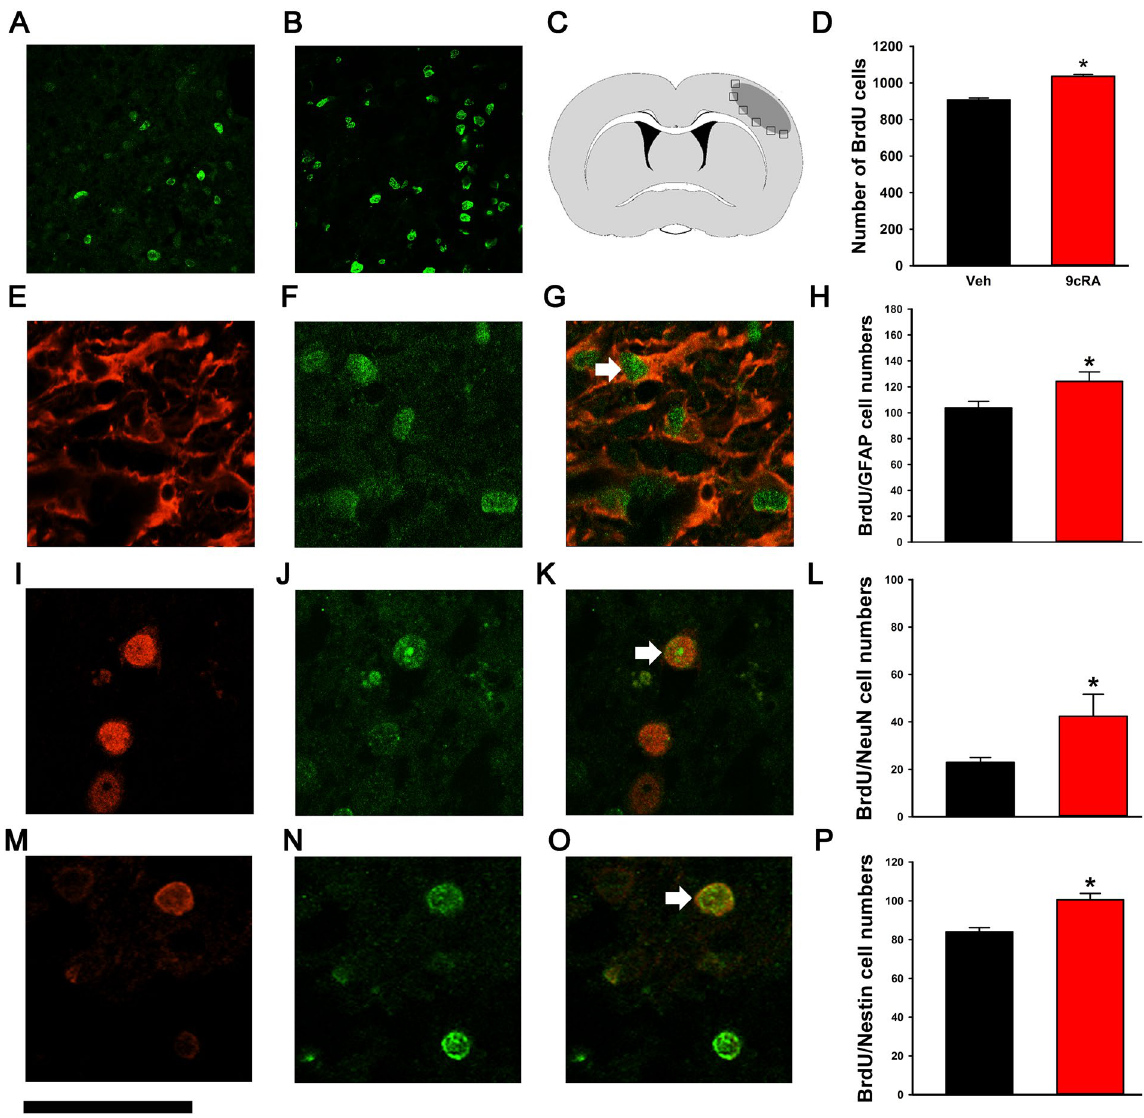
Figure 5. Post-stroke treatment with 9cRA increased BrdU immunoreactivity and cell differentiation in the lesioned cortex. Stroke animals (n = 13) received 9cRA (n = 6) or saline (n = 7) from days 3 to 14. BrdU was given (50 mg/kg, bid) from days 3 to 14. Animals were sacrificed on day 15. Representative BrdU immunoreactivity in the peri-lesioned area of animals receiving ( A ) vehicle and ( B ) 9cRA. The density of BrdU-labeled cells in the peri-lesioned zone (boxes surrounding the lesioned or shaded area) was measured and averaged from three adjacent sections at the level of the anterior commissure ( C ). ( D ) Intranasal administration of 9cRA significantly increased the number of BrdU-positive cells per visual field (410 × 410 µ m) in the lesioned cortex (p < 0.001, t-test). Confocal microscopy was used to examine the colocalization of the immunoreactivity of BrdU ( F , J , N ) with GFAP ( E ), NeuN ( I ), or nestin ( M ) in the perilesioned cortex. The density of cells co-labelled with BrdU and these markers (arrows, G , K , O ) were quantitatively analyzed. 9cRA treatment significantly increased the density of BrdU cells co-expressing ( H ) GFAP (p = 0.035), ( L ) NeuN (p = 0.001), and ( P ) nestin (p = 0.014). Calibration: A and B: 100 µ m; E-G, I-K an M–O: 42 µ